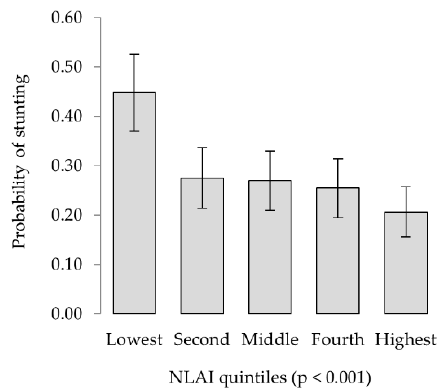
Figure 6. The non-livestock asset index was significantly associated with the probability of child stunting, with a significantly higher likelihood identified amongst the lowest wealth quintile ( p < 0.001).